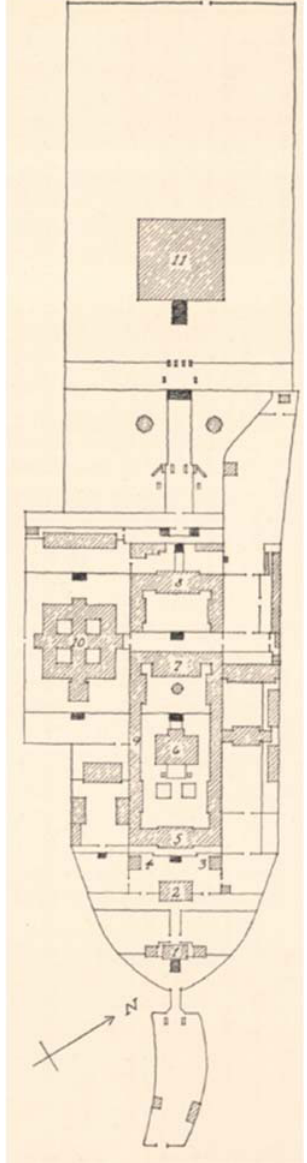
Figure 7. Plan of Biyun Monastery, Mt. Xishan, Beijing, Ming to Qing period, 1368–1911: (1) Mountain Gate; (2) Hall of Heng-Ha (Guardians); (3) bell-tower; (4) drum-tower; (5) Hall of Heavenly Kings; (6) Jade Emperor’s Hall; (7) Guanyin Hall; (8) Main Hall, (9) Hell, (10) 500 Arhats’ Hall, (11) Pagoda. (Prip ‐ Møller 1937, p. 13, Figure 12).